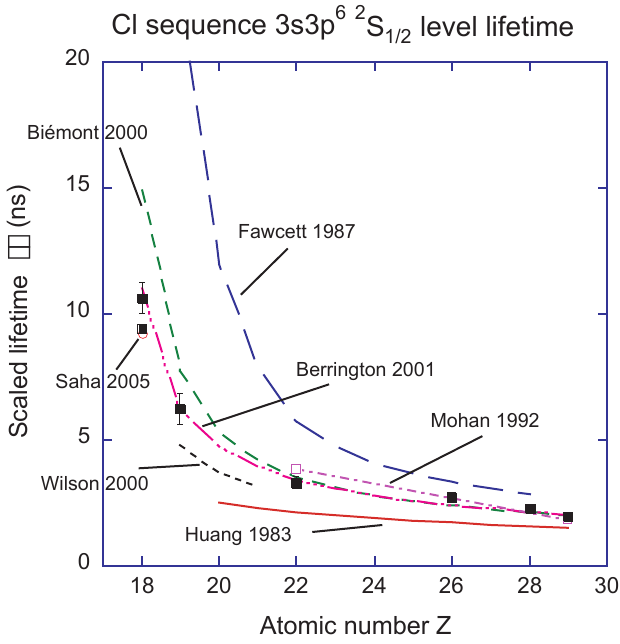
Figure 12. The lifetime τ (scaled by the ion core charge ζ ) of the 3s3p 6 2 S in Cl-like ions. Only a selection of experimental data (full squares) and computational results (open symbols for Ar, Ca and Cu, and eye-guiding lines; most of the computations in the literature do not cover low- Z systems) are shown. Note how at low Z the lifetime predictions diverge by up to an order of magnitude. The computation by Berrington et al. comes closest overall to the low- Z measurements—except for the measurement on Ar II by Lauer et al. [244] (the error bar is smaller than the symbol size) that Berrington did not know of at the time. Saha and Fritzsche, however, matched that one data point well by their computation, but they calculated only this one. The computations by Wilson seemed better than most others at the time—but covered too few elements. Mohan did well in 1992—but why were only two elements